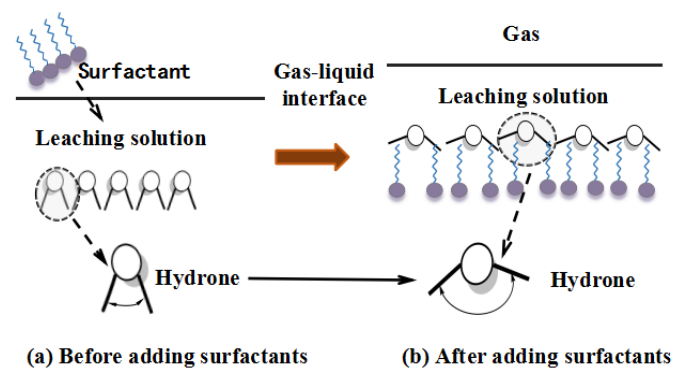
Figure 3. Of surfactants on water Figure 3. of surfactants on water molecules.